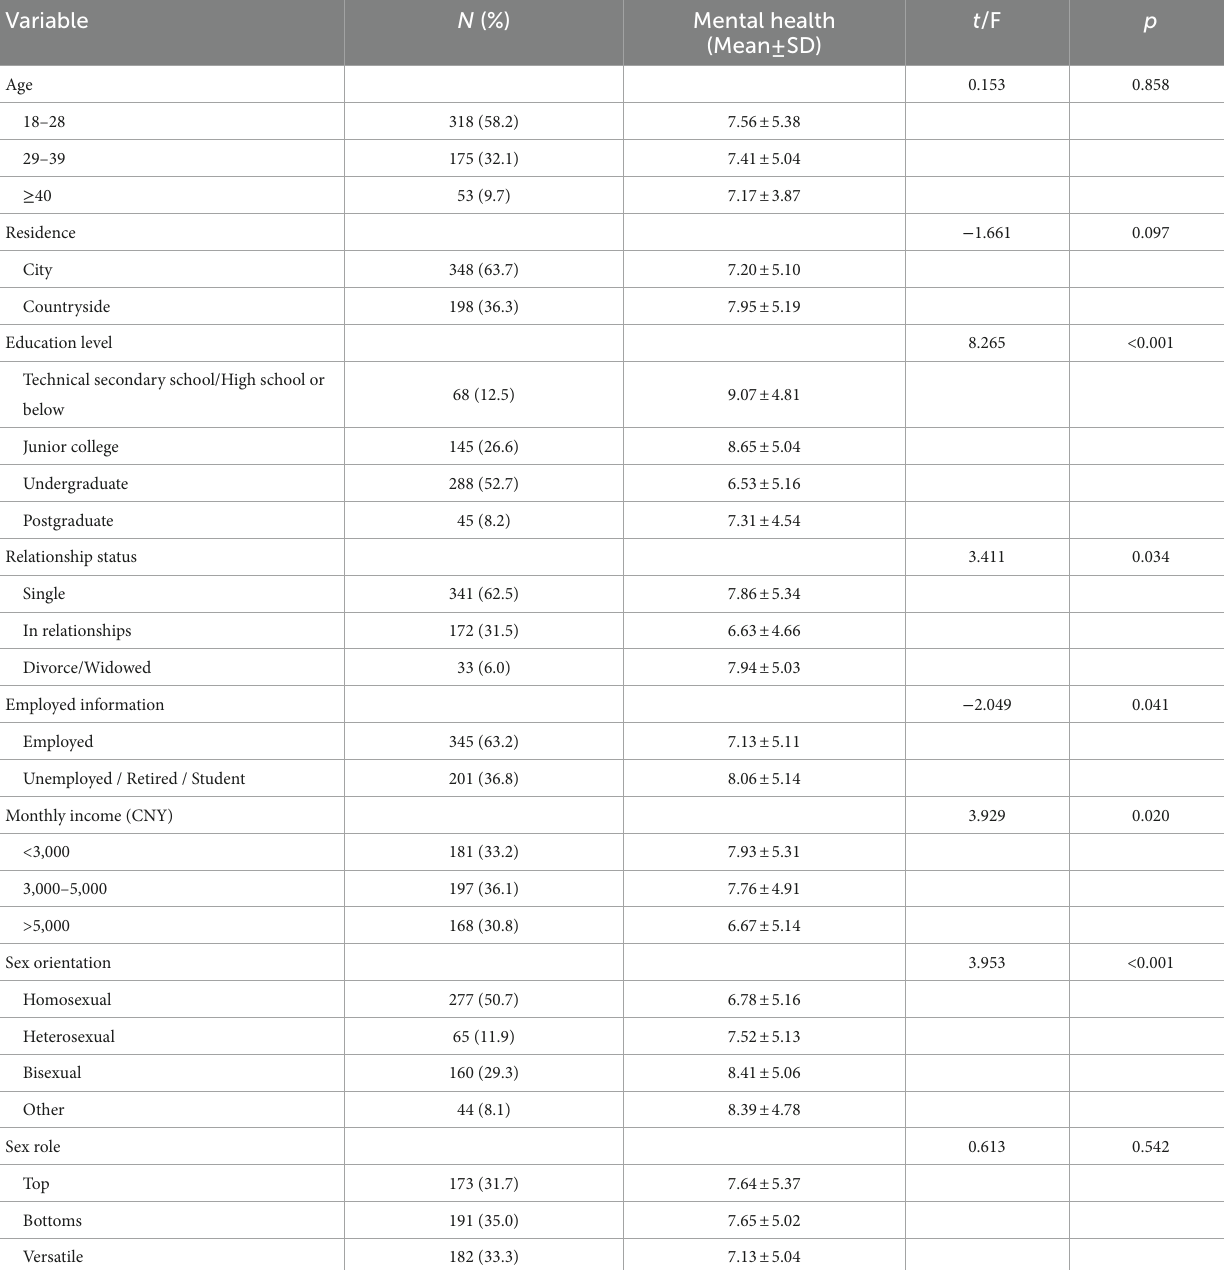
TABLE 1 Effects of demographic characteristics on mental health ( n =